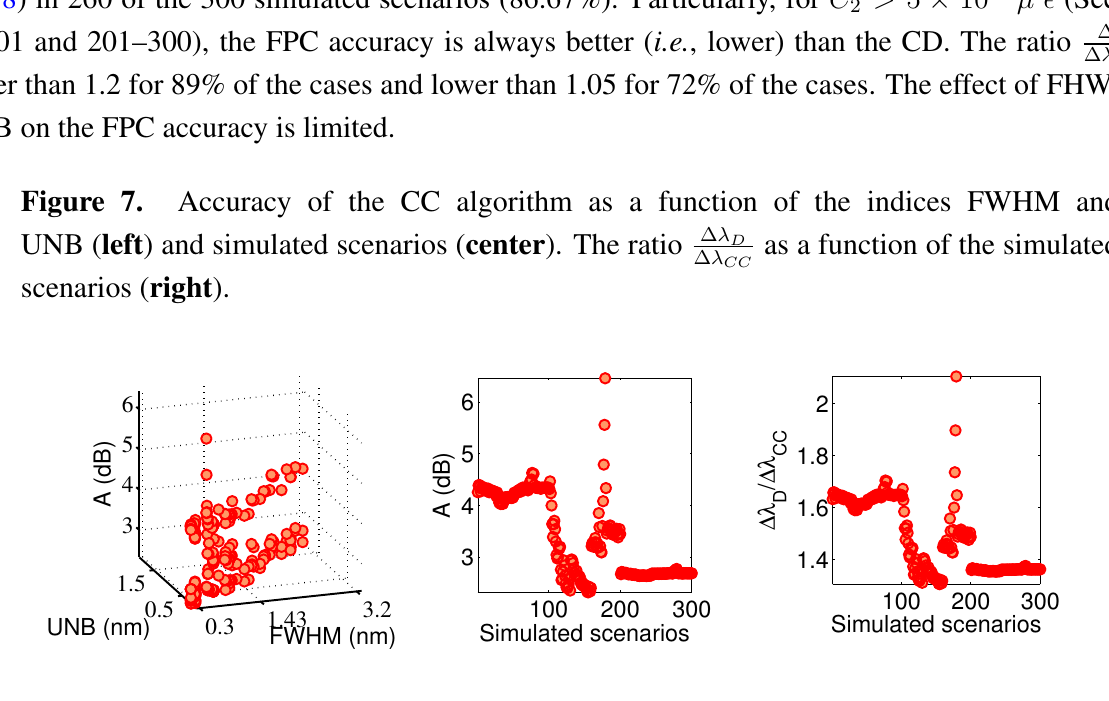
Figure 8. Accuracy of the FPC algorithm as a function of the indices FWHM and UNB ( left ) and simulated scenarios ( center ). The ratio ∆ λ D scenarios ( right